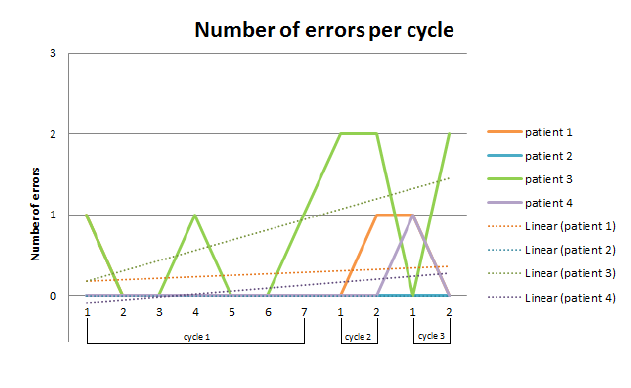
Figure 11: Number of errors committed by each participant per